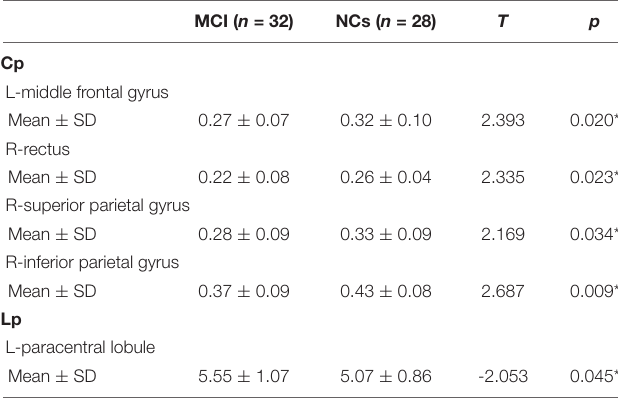
TABLE 3 | Nodal network topology properties in patients with MCI and normal